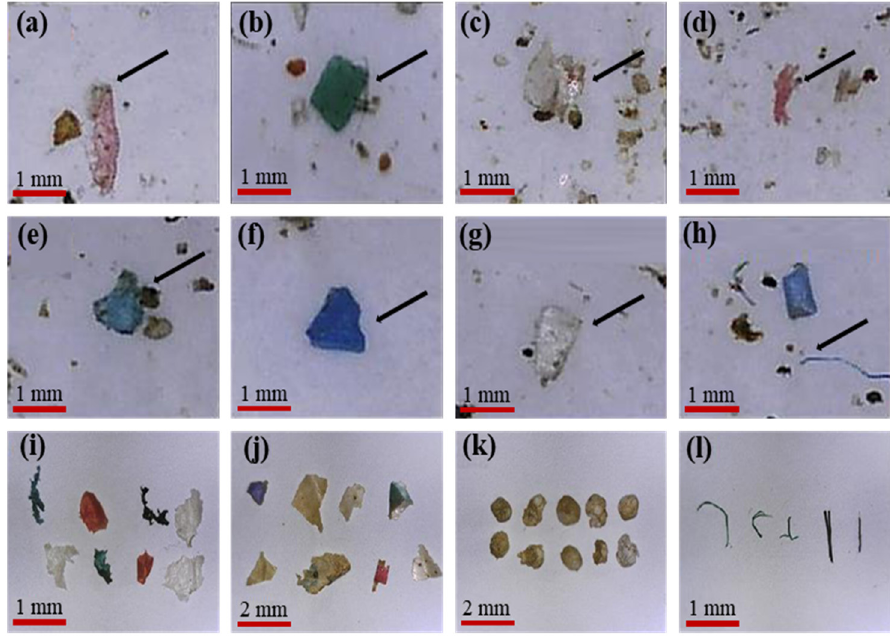
Figure 4. An overview of microplastic morphology: ( a , e , i ) film, ( b , f , j ) fragment, ( c , g , k ) foam, and ( d , h , l ) fiber.